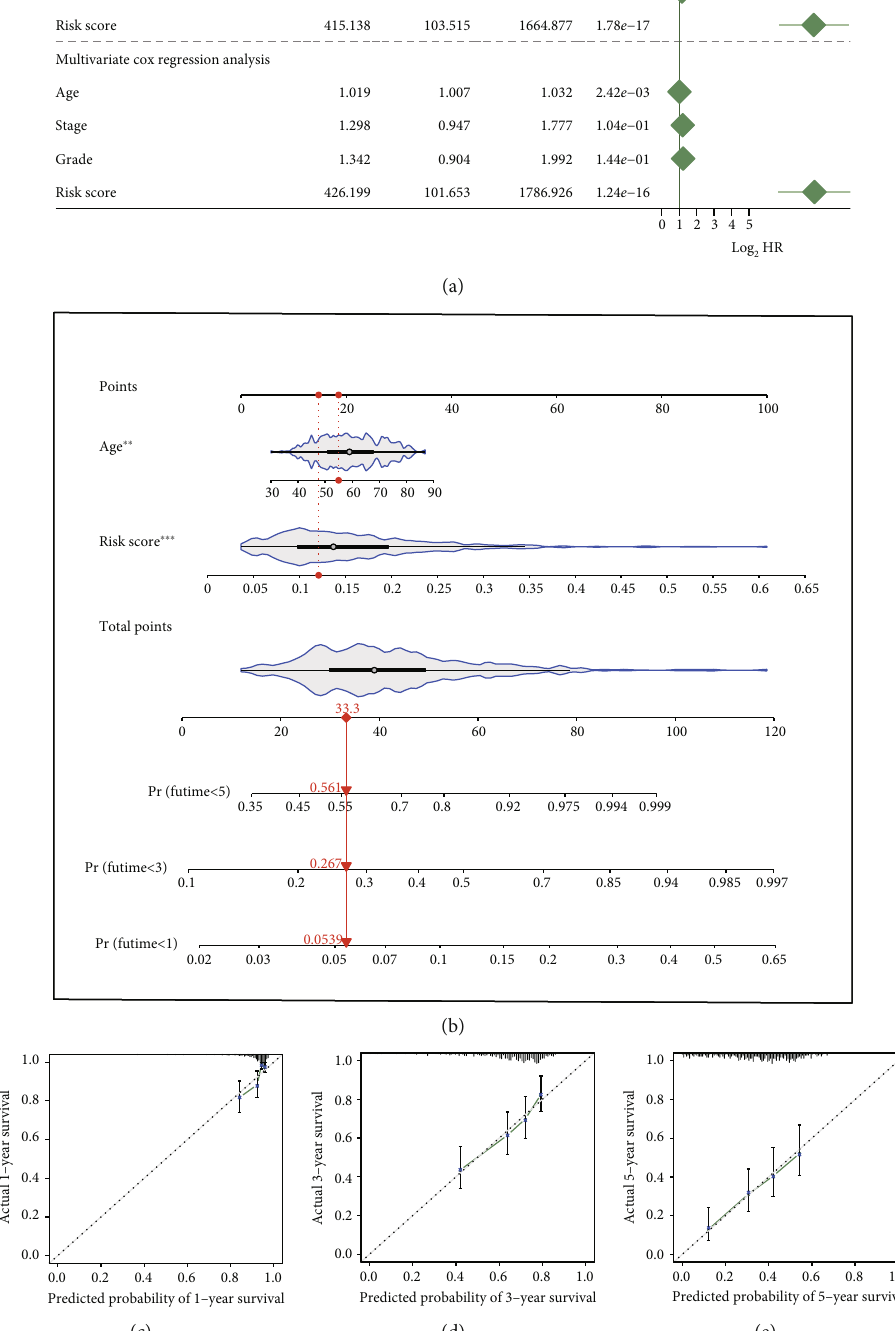
Figure 4: Establishment and veri fi cation of a clinical nomogram. (a) A forest plot for results of Cox regression analysis of risk score, age, stage, and grade. (b) Nomogram. (c) Calibration curves for 1 year. (d) Calibration curves for 3 years. (e) Calibration curves for 5